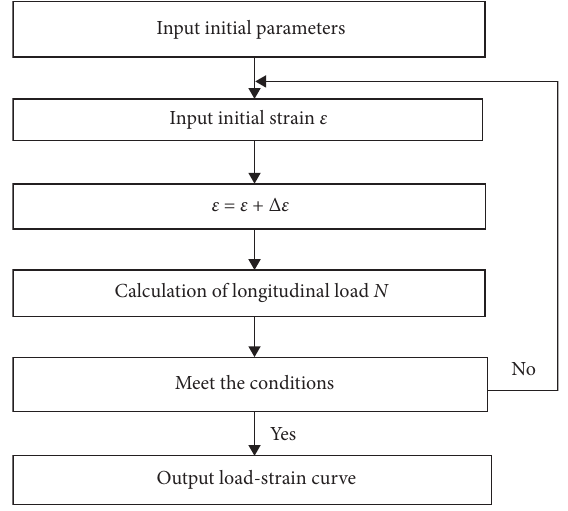
Figure 3: Sketch of